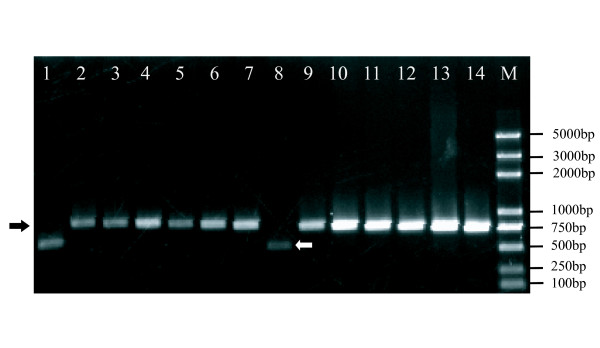
PCR verification in 14 silkworm strains for BmMITE-2. Lanes from 1 to M are: Wu-B, Wu-D, DongDe-201, Wu-E, Lu-10, DaXianTuZhong, FuRongHuiLuan, PeiXianZhong, Ri-9, HeiZi, ChunSi, QiongShanHaiNan, Ri-110, ShangSanHuBan, DNA marker, respectively. The black arrow points to the BmMITE-2 occupied at this genomic location. The white arrow represents the BmMITE-2 lack at this genomic location.